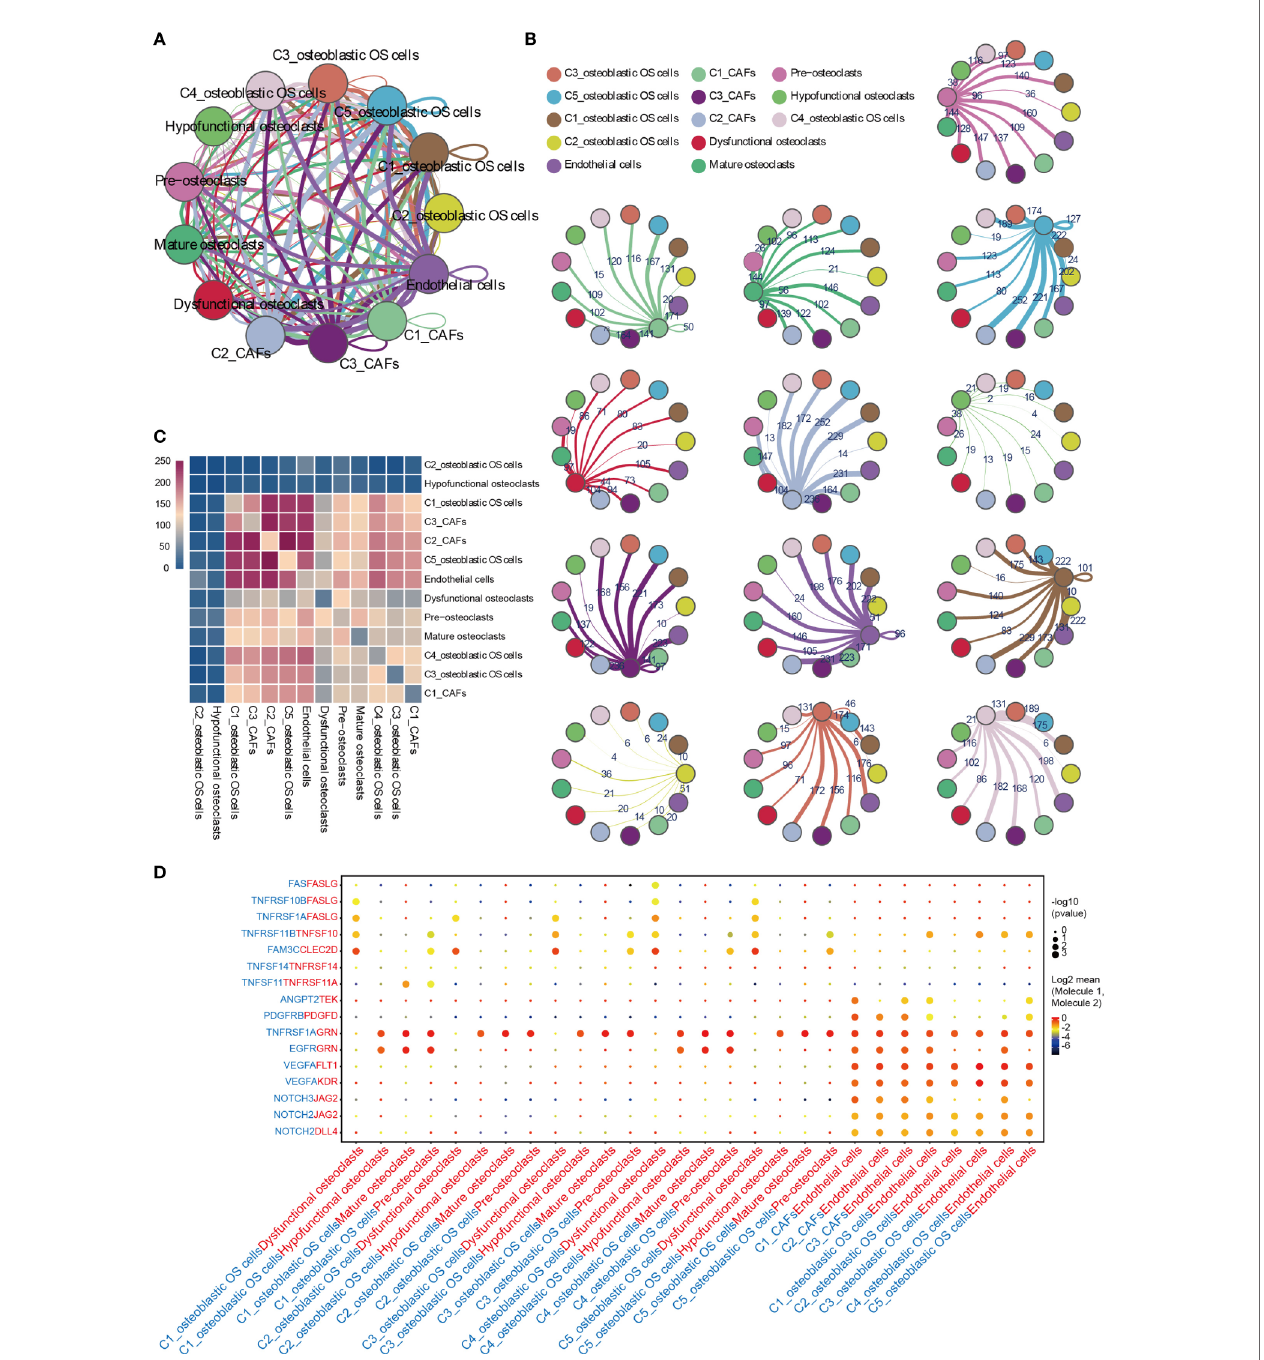
FIGURE 8 | CellPhoneDB analysis of nonimmune cells in the OS. (A) Interaction network constructed by CellPhoneDB. Each line color indicates the ligands expressed by the cell population represented by the same color (labeled). The lines connect to the cell types that express the cognate receptors. The line thickness is proportional to the number of ligands when cognate receptors are present in the recipient cell type. (B) Detailed view of the ligands expressed by each major cell type, and the cells expressing the cognate receptors primed to receive the signal, are shown. Numbers indicate the quantity of ligand-receptor pairs for each intercellular link. (C) Heat map showing the number of potential ligand-receptor pairs among the predicted cell types. (D) Overview of selected ligand-receptor interactions of cells in OS. OS, osteosarcoma; TME, tumor microenvironment.